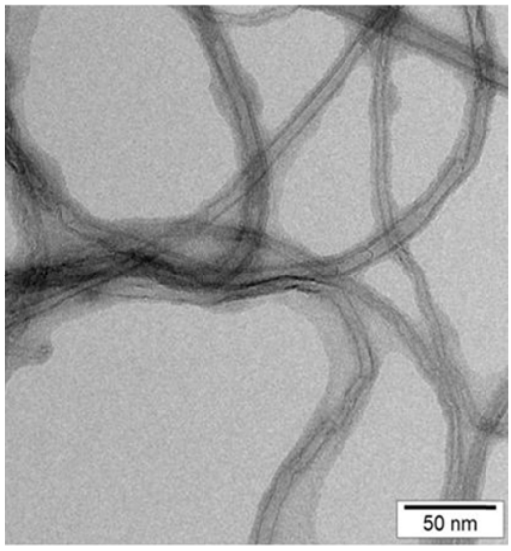
Fig. 1. TEM M image of MWCCNTs Fig. 1. TEM image of